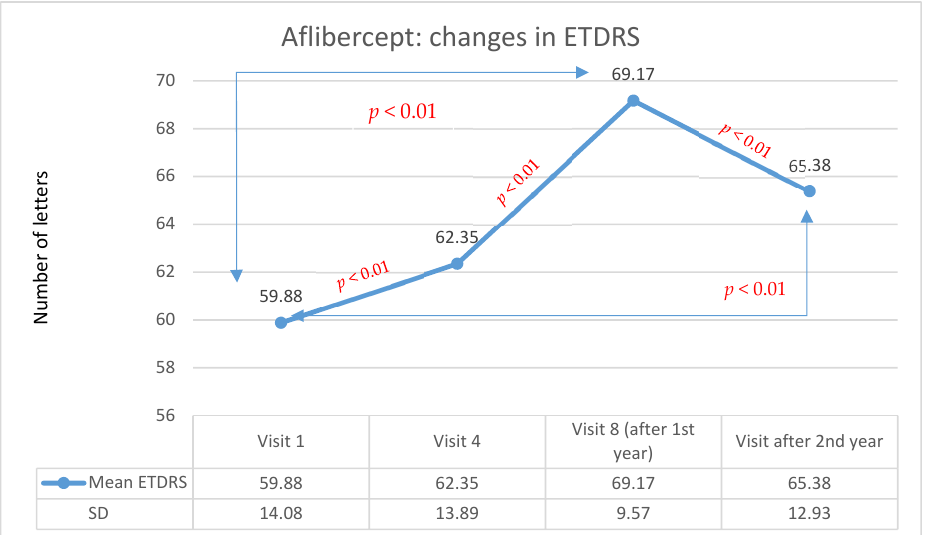
Figure 1. Changes in visual acuity in the ETDRS during individual follow-up visits for the Aflibercept group. Red indicates statistically significant differences (Wilcoxon test).